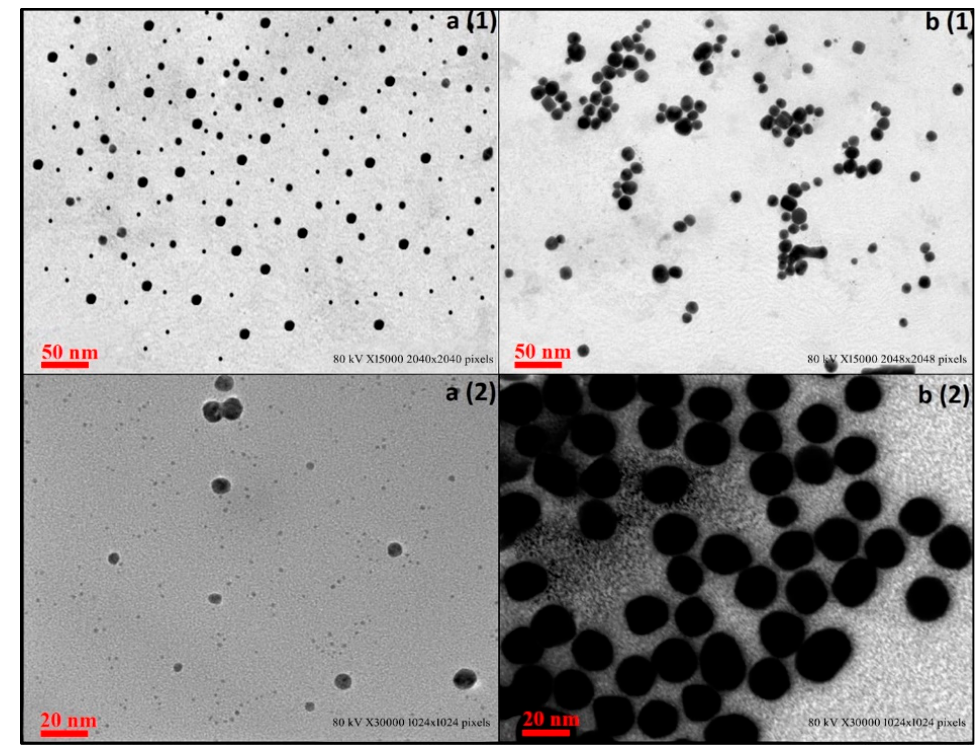
Figure 5. TEM Micrograph images of GNPs ( a1 , a2 ) and CGNPs ( b1 , b2